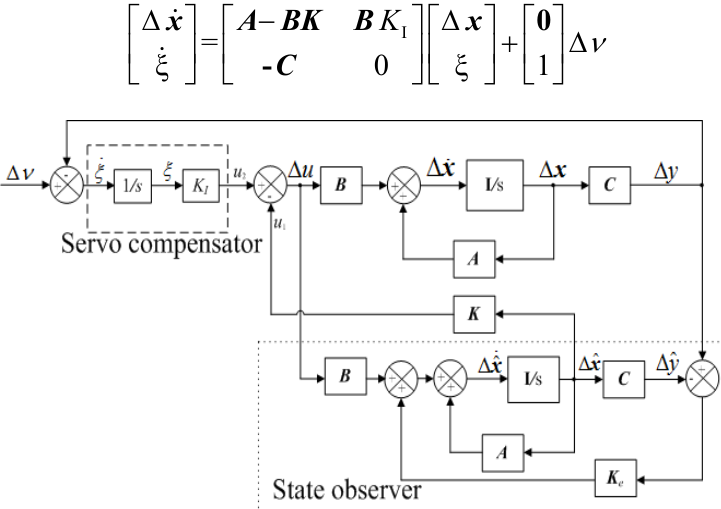
Figure 4. Structure diagram of the compound